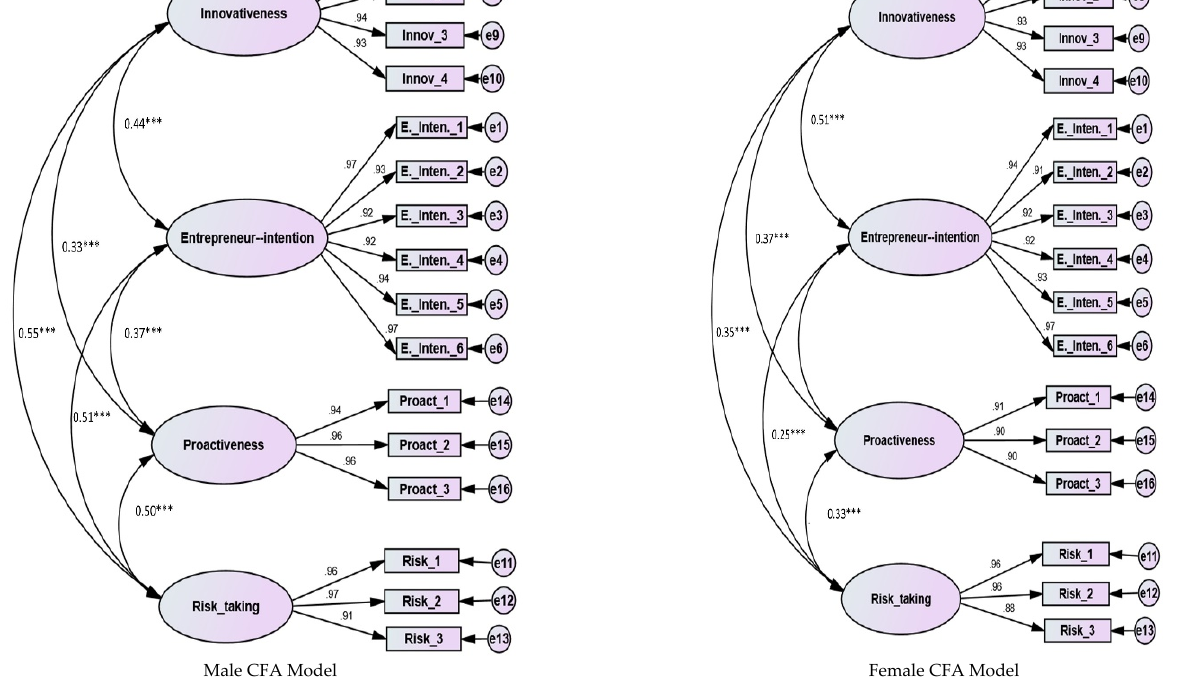
variance extracted” (AVE) values: entrepreneurship intention (Male, 0.887; Female, 0.866), risk-taking (Male, 0.893; Female, 0.867), innovativeness (Male, 0.845; Female, 0.826), and pro-activeness (Male, 0.910; Female, 0.816), surpassed the cut-off point of 0.50, indicating adequate convergent validity (Kline,